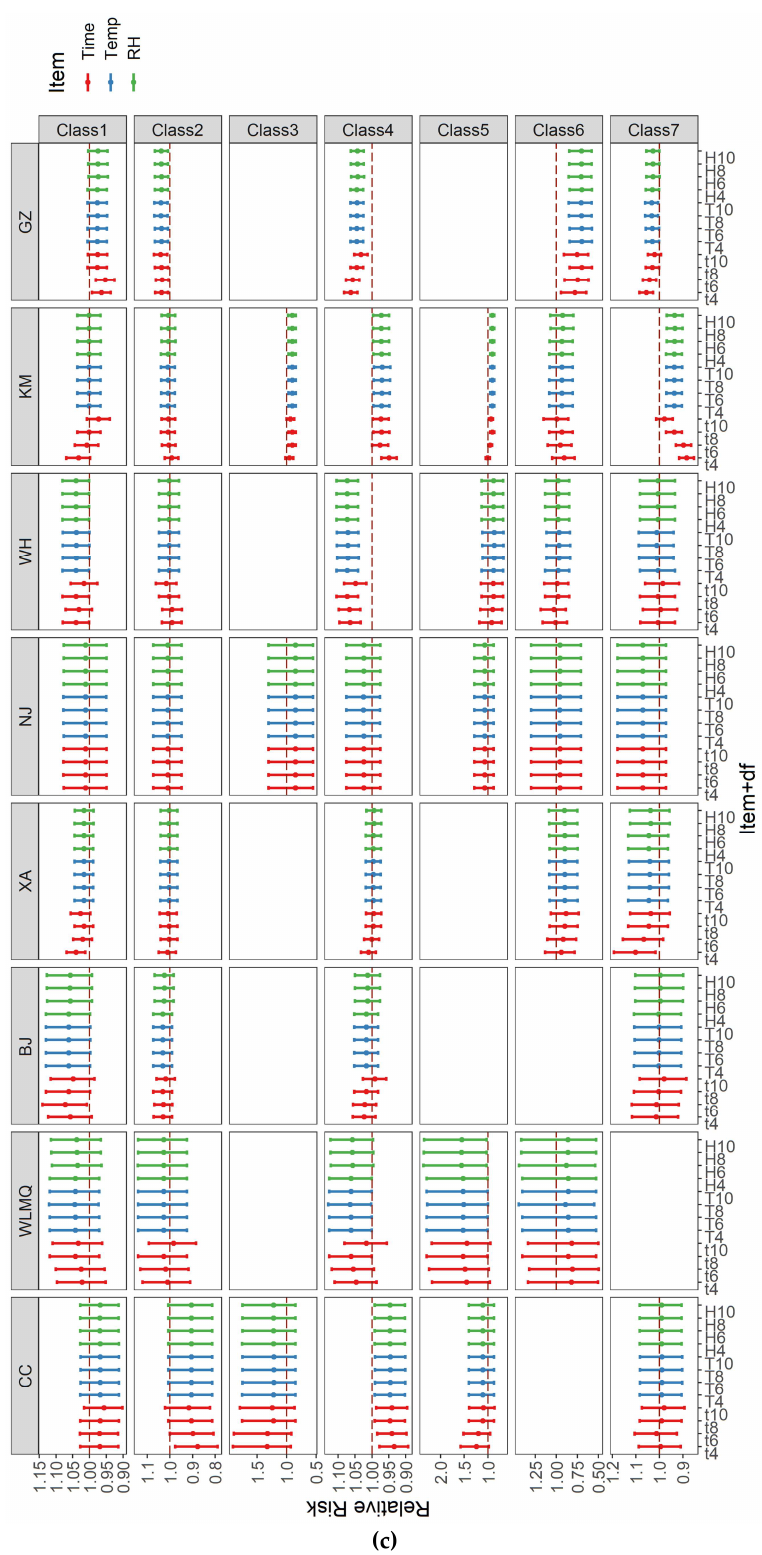
Figure A1. A change in the number of degrees of freedom at intervals of 2 within a range of 4 to 10 df, for time trend, temperature, and relative humidity respectively, during all-year ( a ), warm season ( b ), and cold season ( c ).